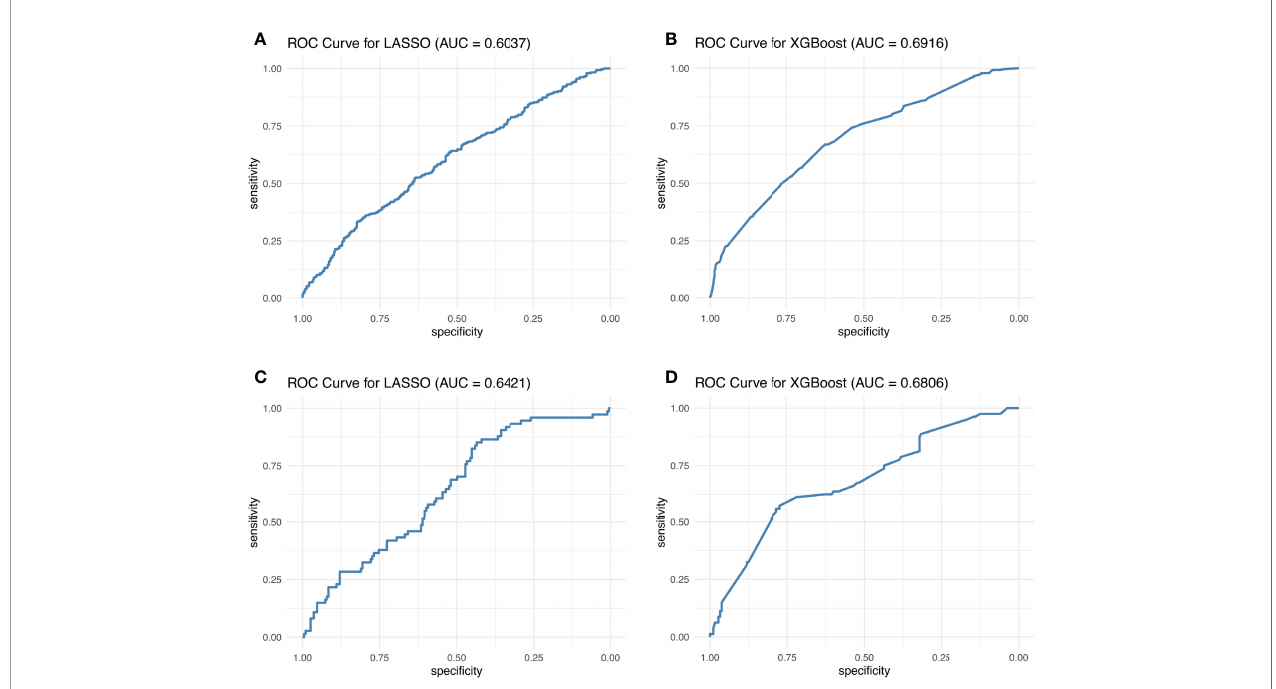
FIGURE 3 | Best ROC curves of the 10-biomarker panel evaluated by the LASSO and XGB methods. The best ROC curves were obtained at 8:2 cohort ratio of the training and test datasets by the LASSO and XGB